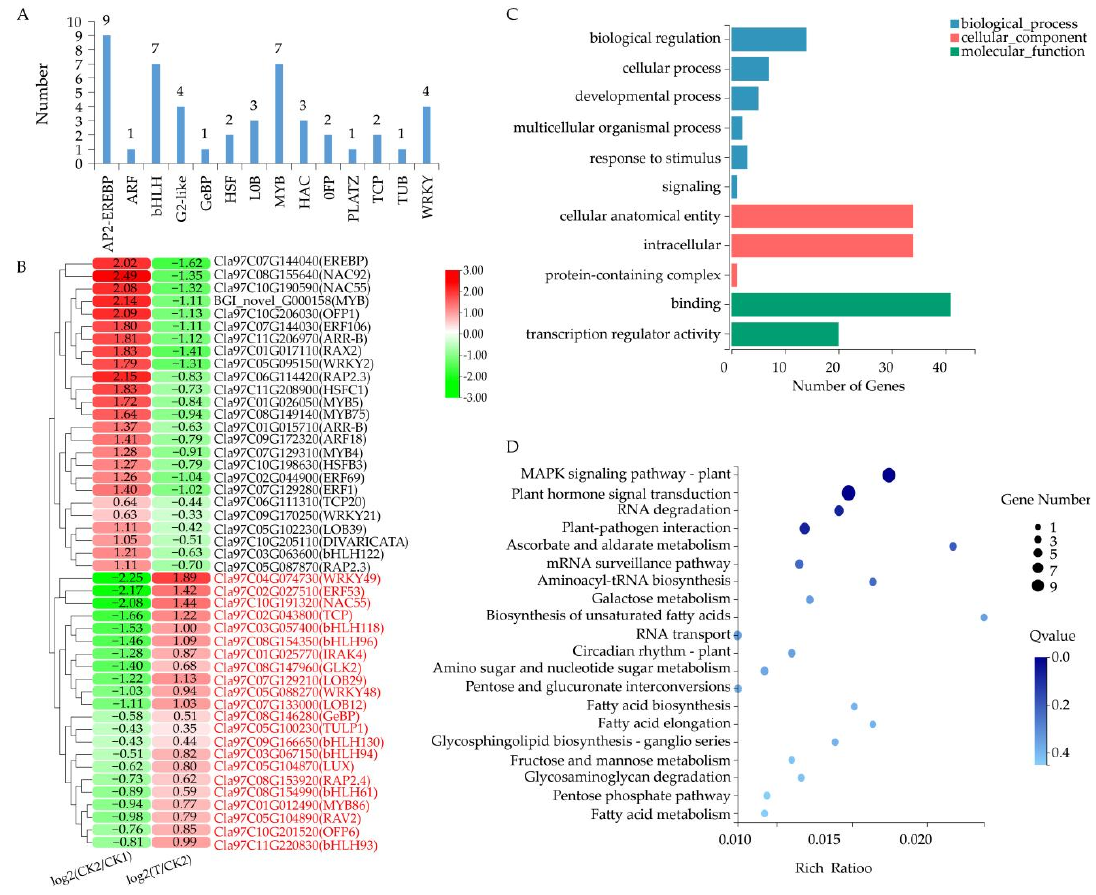
Figure 5. Analysis of differentially expressed TFs. ( A ) Classification analysis of TFs. ( B ) Analysis of expression levels of TF encoding genes. The color scale ranges from − 3 to 3, with green indicating downregulation and red indicating upregulation (see the color set scale). ( C ) GO classification of TFs. ( D ) KEGG pathway enrichment analysis of TFs. CK1 represents watermelon seedlings cultured in normal Hoagland solution; CK2 represents watermelon seedlings cultured in Hoagland solution containing 150 mm NaCl, and T represents watermelon seedlings cultured in Hoagland solution containing 150 mM NaCl and 20 mM